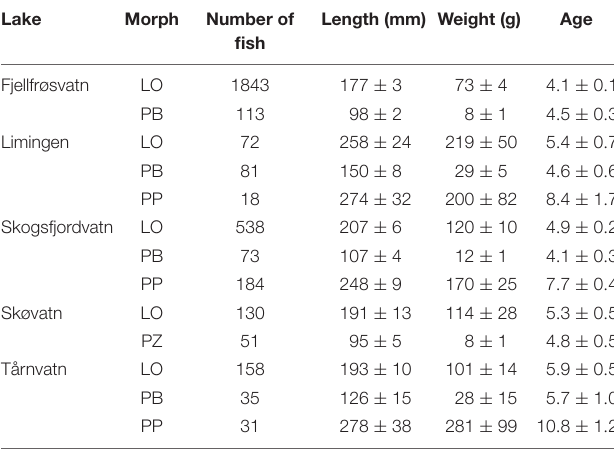
TABLE 1 | Metadata and sample size of Arctic charr samples from five Norwegian lakes used in the